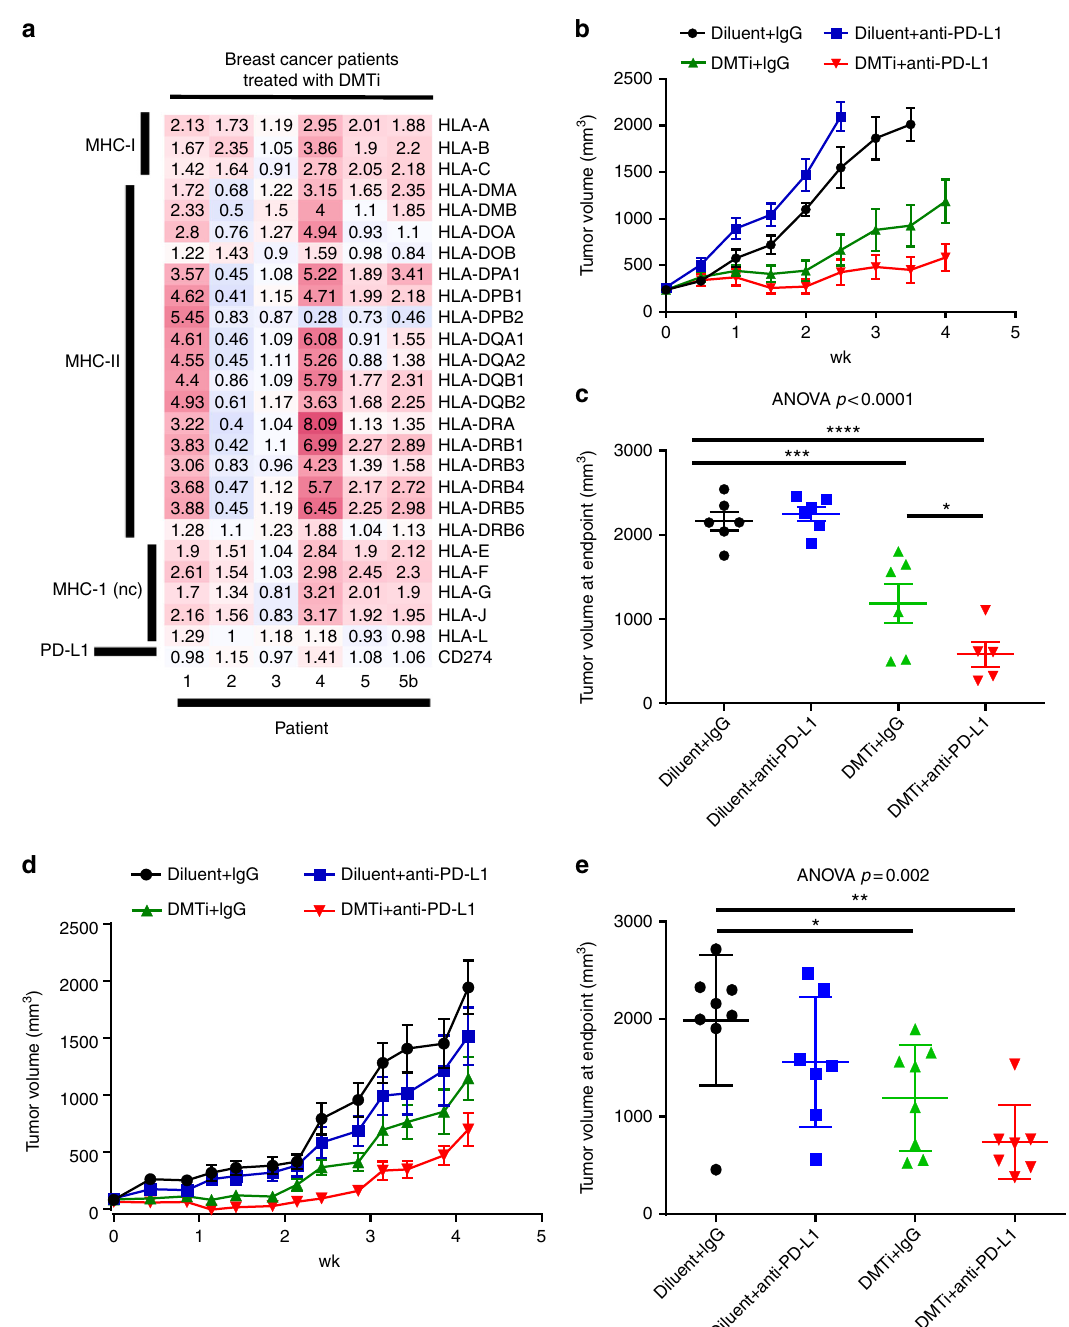
Fig. 5 Epigenetic treatment augments MHC-I and MHC-II in breast cancer patient samples, and potentiates response to anti-PD-L1 therapy in mice. a The heatmap illustrates post/pre-treatment mRNA expression ratio of MHC-I, MHC-II, and PD-L1 in 5 pairs of triple negative breast cancer patient samples. Each pair includes “ Pre ” (before 5 ’ -azacitidine, AZA, and entinostat treatment) and “ post ” (ratio of 8wks:baseline in patients 1 – 5 or ratio of 6mos: baseline [patient 5b] after AZA and entinostat treatment). MHC-I nc: non classical MHC-I b Tumor growth curves from MMTV-Neu tumor-bearing FVB/n mice treated with guadecitabine daily for 3 days, followed by twice weekly anti-PD-L1 for 2 weeks (or appropriate controls). Mice were sacri fi ced when tumor volume measurements fi rst exceeded 2 cm 3 , or at 4 weeks whichever occurred fi rst. c Final tumor volumes at the humane endpoint by treatment group from ( b ). Differences in fi nal tumor volume (mean ± SEM) were compared by ANOVA followed by Tukey ’ s post-hoc test to compare relevant groups. * p < 0.05; *** p < 0.001; **** p < 0.0001 for individual comparisons. d Tumor growth curves from MMTV-PyVmT tumor-bearing FVB/n mice treated with guadecitabine daily for 3 days, followed by twice weekly anti-PD-L1 for 2 weeks (or appropriate controls). Mice were sacri fi ced when tumor volume measurements fi rst exceeded 2 cm 3 , or at 4 weeks whichever occurred fi rst. e Final tumor volumes at the humane endpoint by treatment group from ( d ). Differences in fi nal tumor volume (mean ± SEM) were compared by ANOVA followed by Tukey ’ s post-hoc test to compare relevant groups. * p < 0.05; ** p < 0.01 for individual